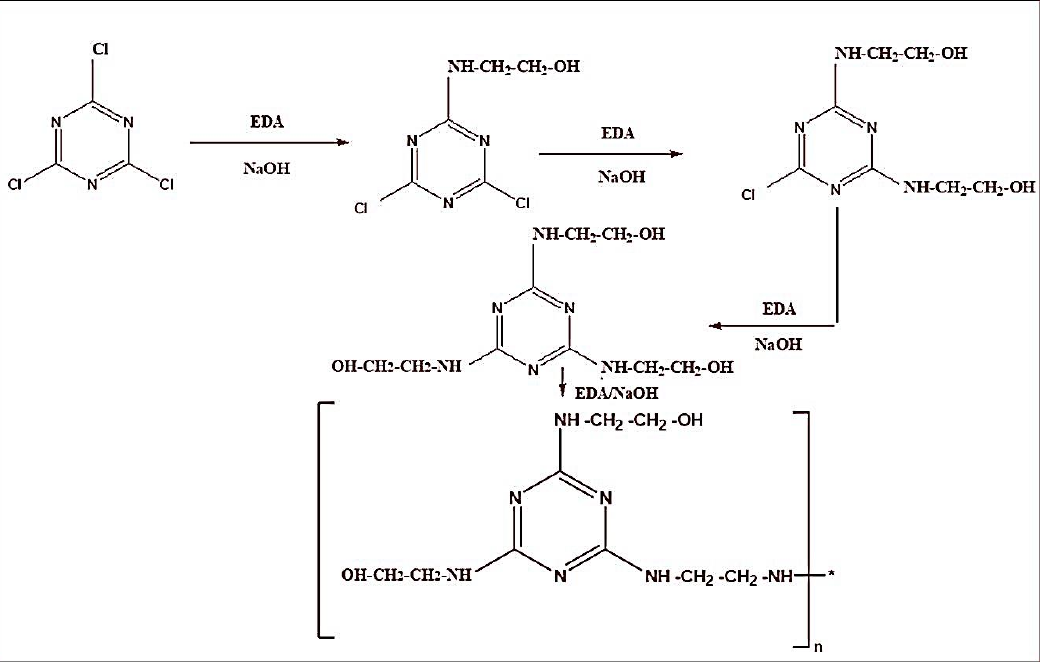
Table 1. Composition of the intumescent flame retardation